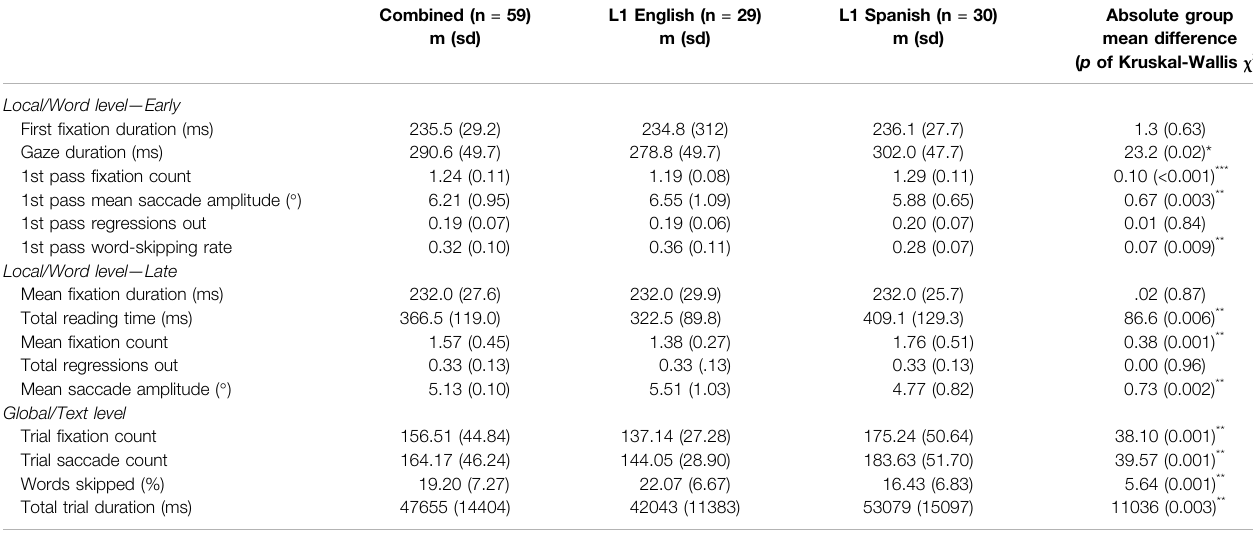
TABLE 7 | Descriptive statistics for eye-tracking measures, by group.